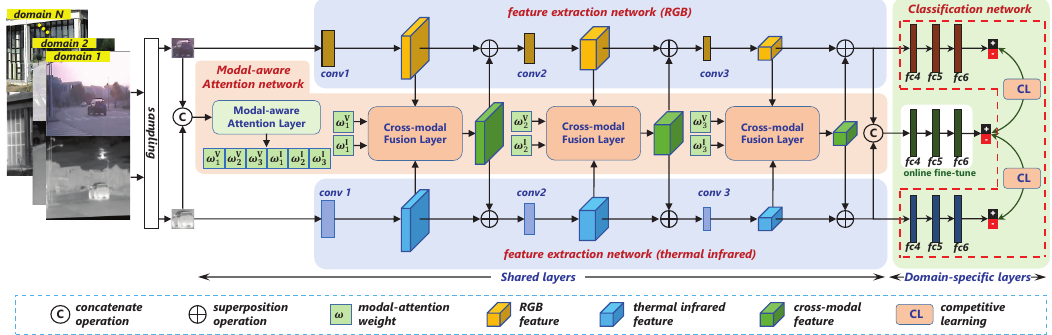
Figure 1. The overall architectural diagram of the proposed algorithm. Part of the network marked with dotted lines is only used for offline competition